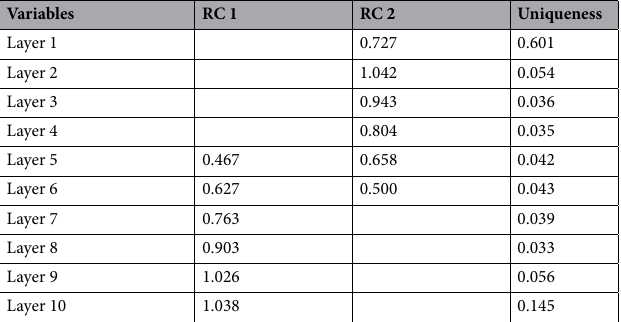
Table 4. PCA results. Loading coefficients for RC1 and RC2 components. The first column reports all the variables included (T 1 values in cortical depth-levels from 1 to 10). RC1 and RC2 columns represent variable loadings on that specific component. Uniqueness shows the percentage of the variance of each variable not explained by the